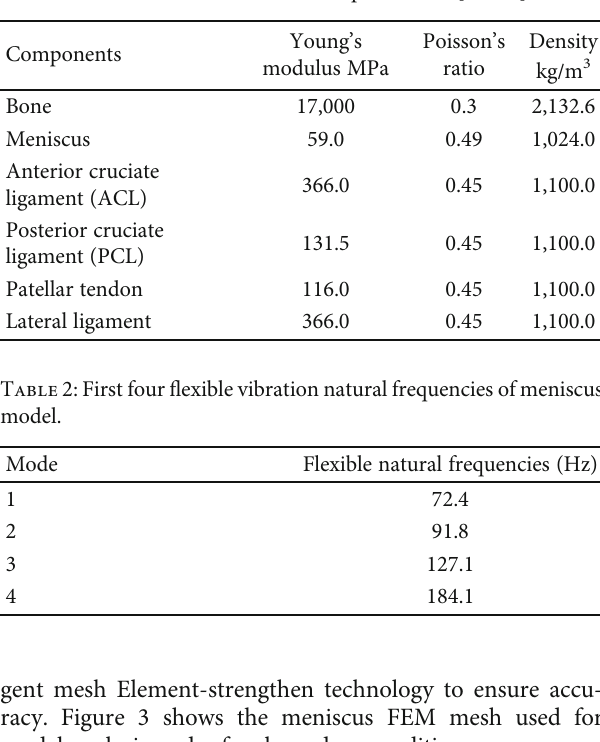
Figure 4: FEM mesh of the complete knee model (CKM) [25]. Table 1: Real human material parameters [29 – 34].